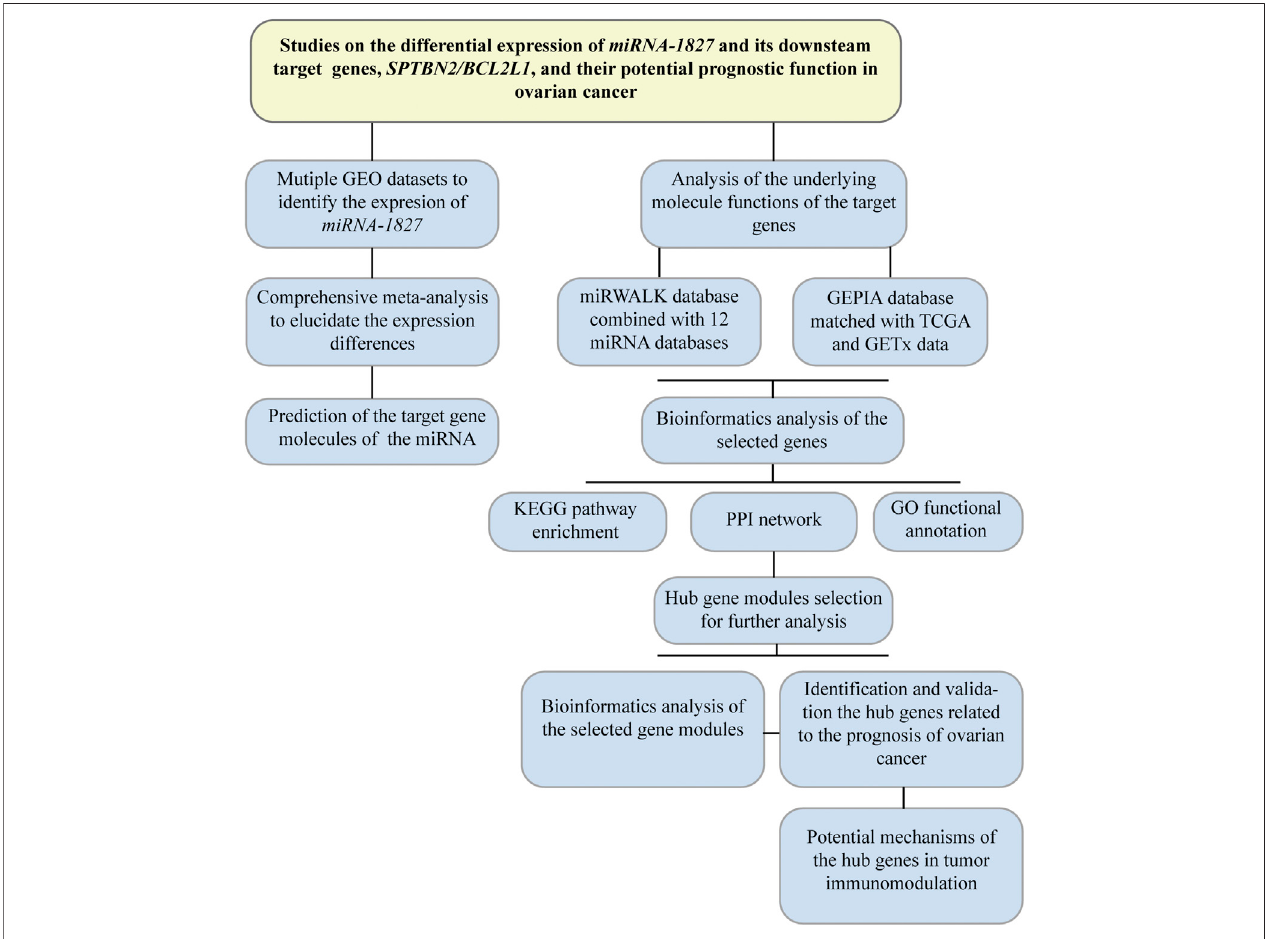
FIGURE1| Flowdiagram oftheresearchdesign. This fl owchartpresentedacomprehensive meta-analysis to validate the expression among differentmicroarrays inOV,andbioinformaticanalysiswasperformedtoinvestigatetheputativetargetgenes.Hubgeneswere fi lteredoutforfurtherresearchontheirprognosticsigni fi cance.